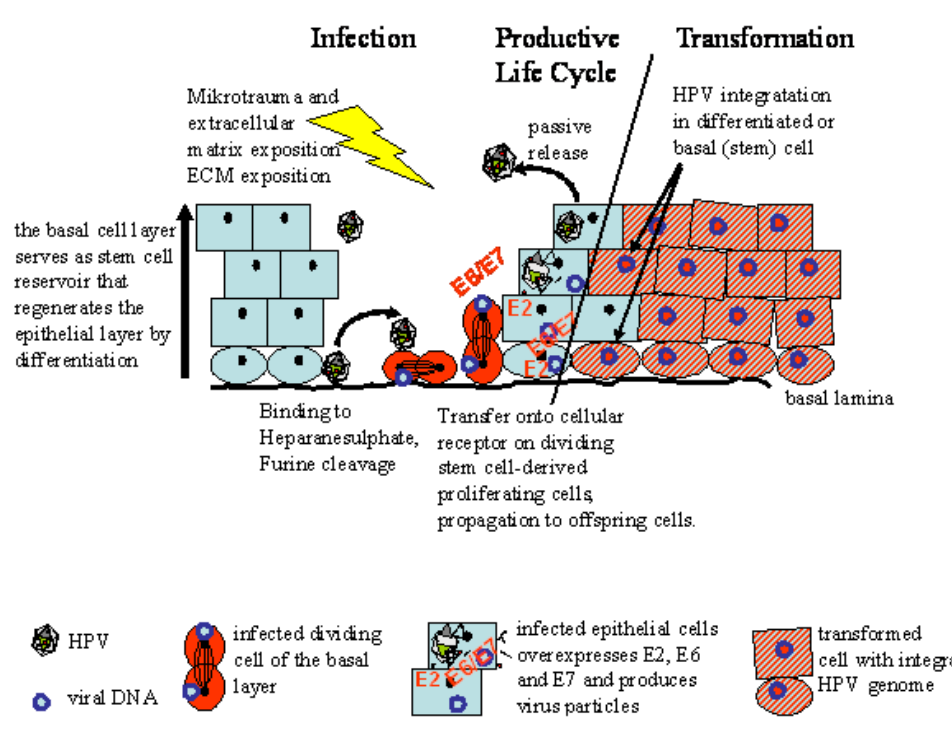
Figure 1. The HPV life cycle involves epithelial stem cell-like cells. Through micro-injury, HPV reaches the basal compartment of the epithelium and binds to extracellular matrix components of the basal lamina. Upon contact to dividing cells, the virus infects these cells and may become quiescent together with the reacquired stem cell phenotype. This allows prolonged persistence of viral infection and fixation of the infection in the epithelial stem cell. This may, in part, also be balanced by the viral oncogenes E6, E7 and the transcription repressor E2. When epithelial cells differentiate, the viral genetic program is switched and structural proteins are induced. During tumor progression integration of the viral genome into the host cell genome occurs at a random